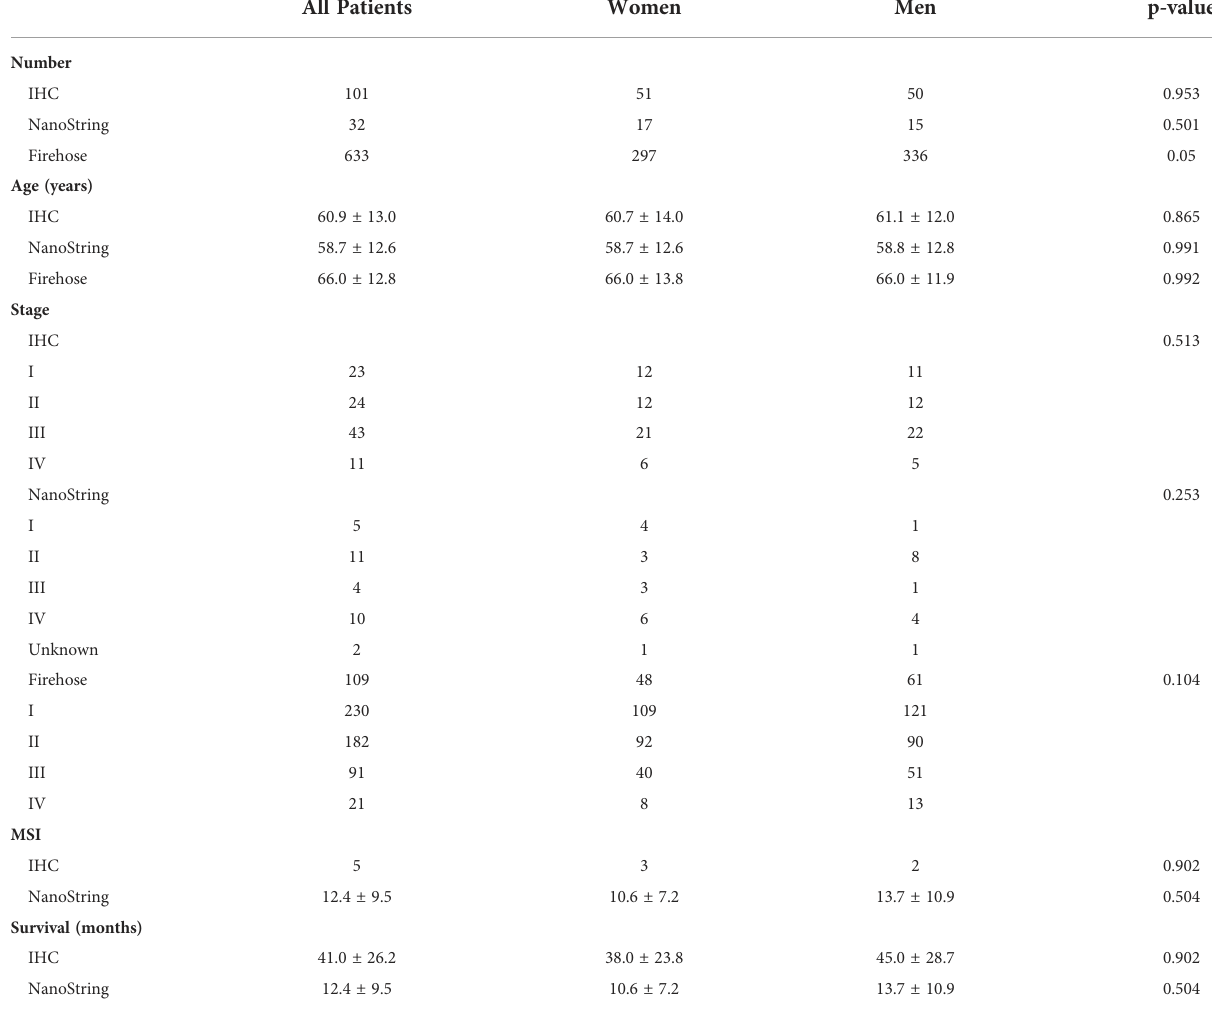
TABLE 1 Clinical characteristics of TMA, NanoString, and TCGA Firehose Legacy patient